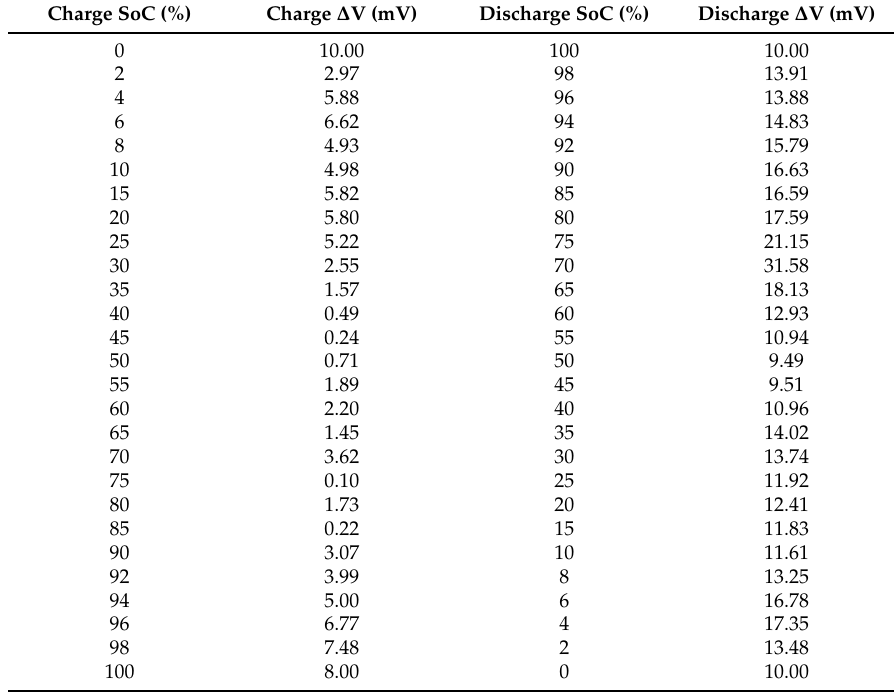
Table 4. SoC ‐ OCV values for charge and discharge for a fresh and aged (90% state ‐ of ‐ health (SoH)) Table 4. SoC-OCV values for charge and discharge for a fresh and aged (90% state-of-health (SoH)) NMC 20 Ah. NMC 20 Ah. Charge SoC